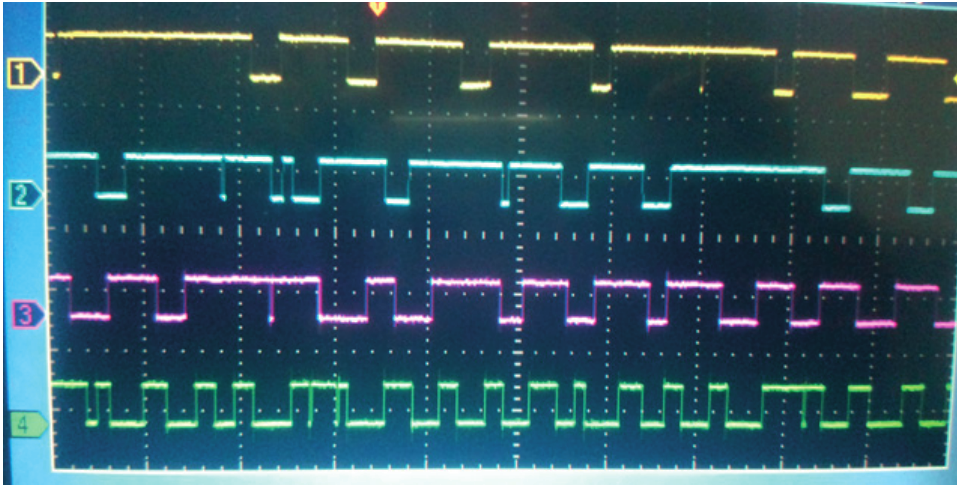
Figure 7. Measured outputs for different Δ C layer at 25